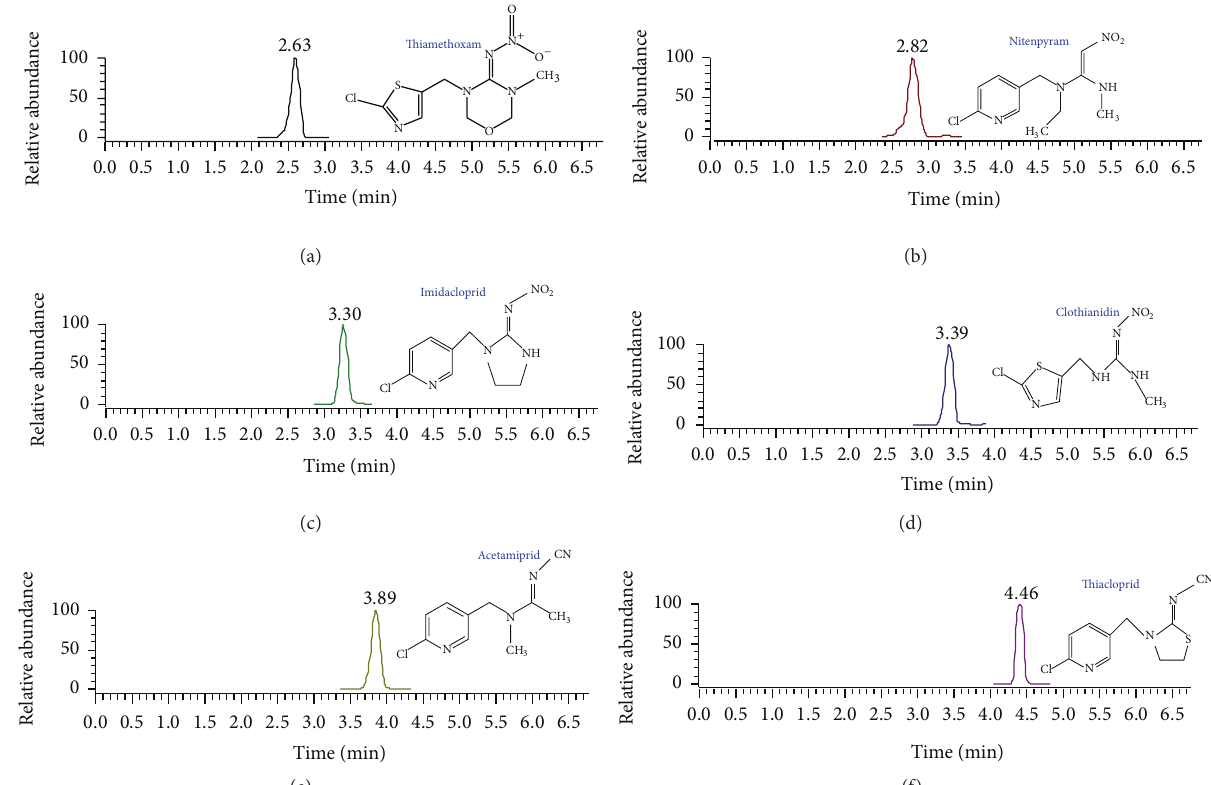
Figure 1: Representative UHPLC/MS-MS chromatogram of studied neonicotinoids for matrix-matched standards 40 𝜇 g/kg.